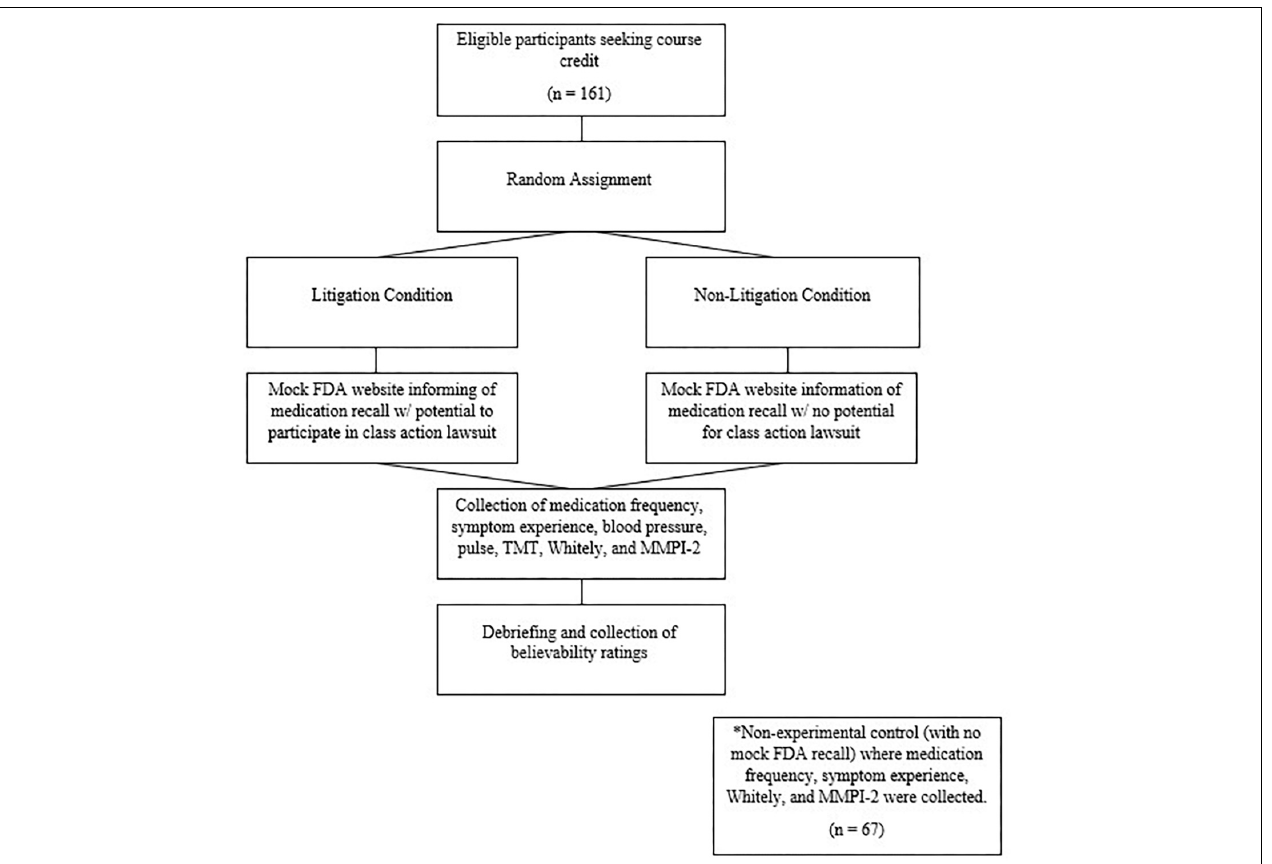
FIGURE 1 | Flowchart describing the procedure.